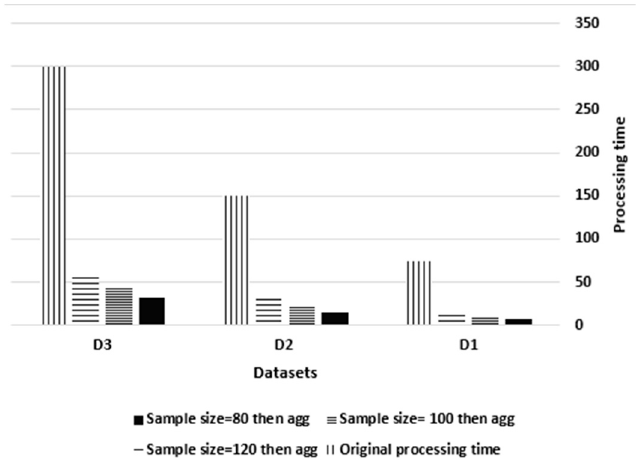
Figure 13. Processing time after aggregation vs. sample